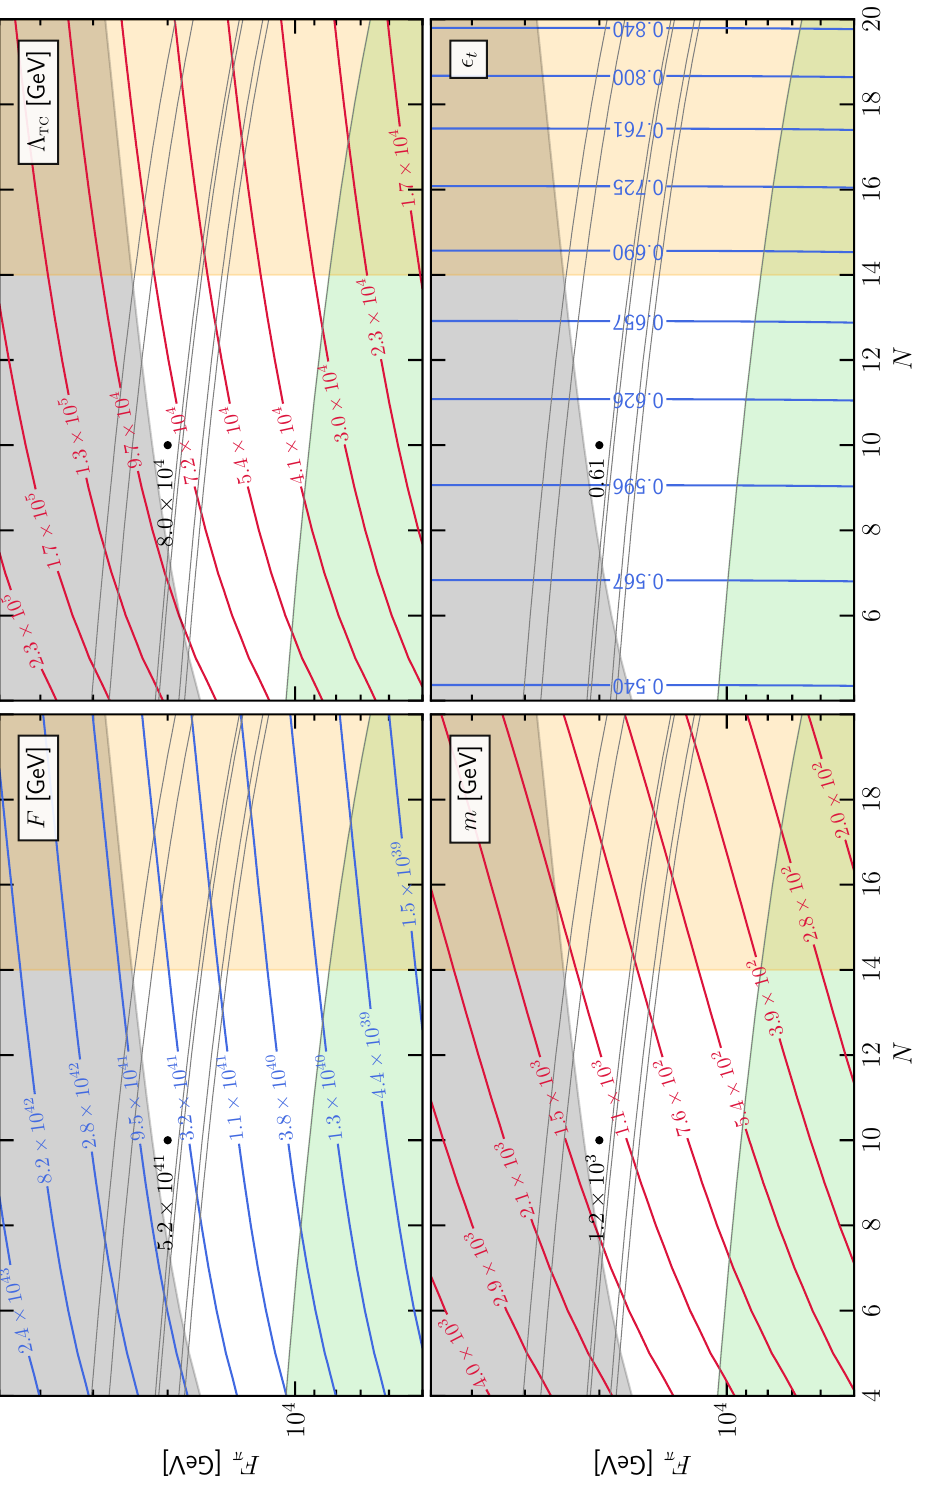
Figure 4 . As for (cid:12)gure 3, but showing the phenomenologically less interesting results for F , (cid:3) tc , m , and (cid:15) t , as a function of N and F (cid:25)